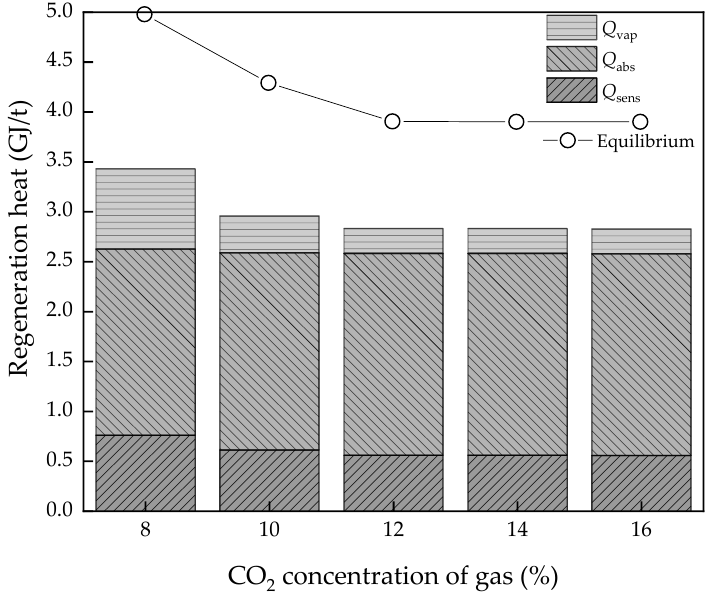
Figure 8. The regeneration heat changes with the CO 2 concentration variation.